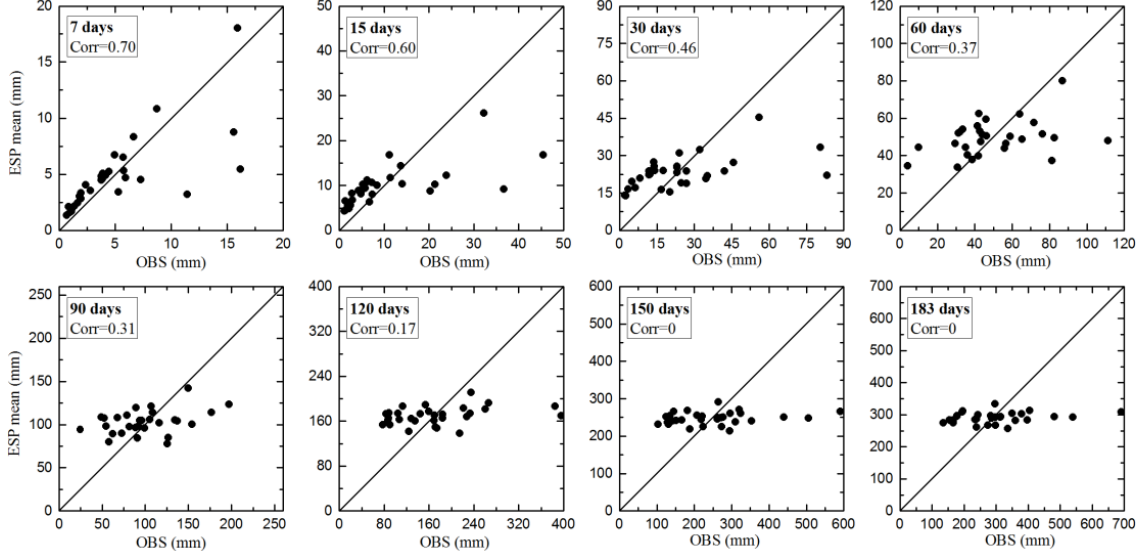
Fig. 5. The same as Fig. 4 but the initial forecast date is 1st Figure 5. The same as Figure 4 but the initial forecast date is 1st July. 610